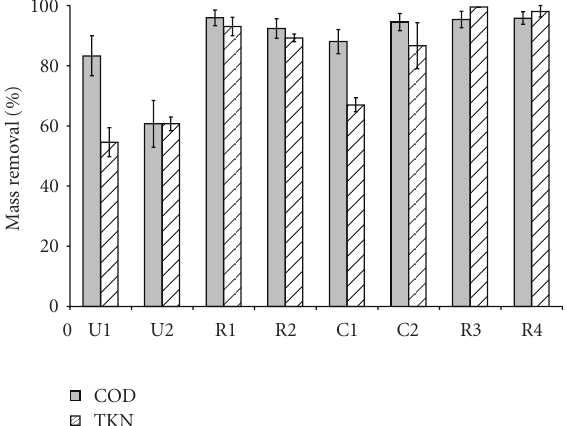
Figure 2: Treatment performances during the 30-day test.